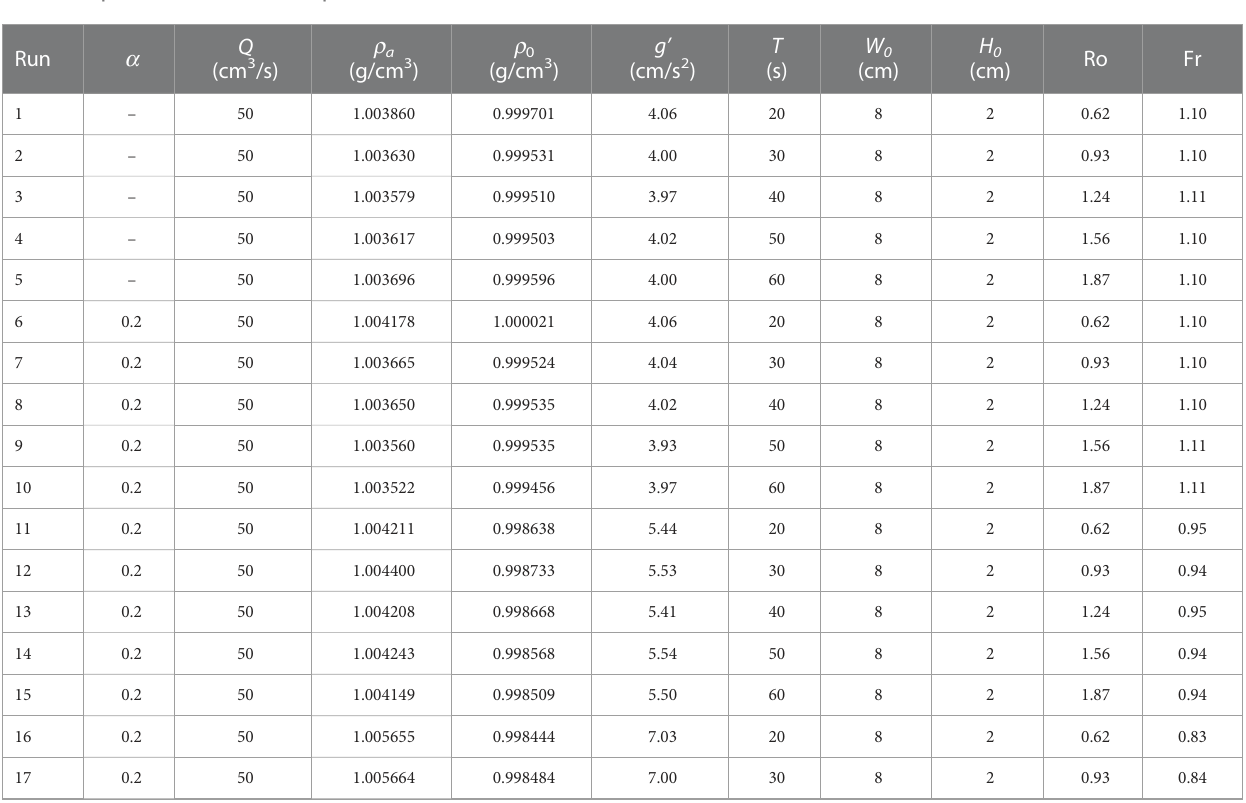
TABLE 1 Experimental conditions and